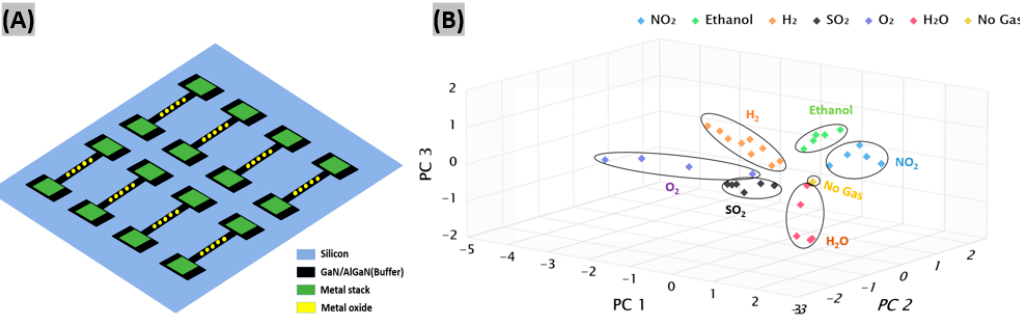
Figure 7. ( A ) The schematic representation of a sensor array comprising of eight metal/metal-oxide coated GaN NWs. ( B ) Score plot from principal component analysis (PCA) analysis for various concentrations of NO 2 , ethanol, SO 2 , H 2 , O 2 and H 2 O, which includes up to 95.1% of the total variance. Figures adapted with permission from [71], Copyright 2020 IEEE.